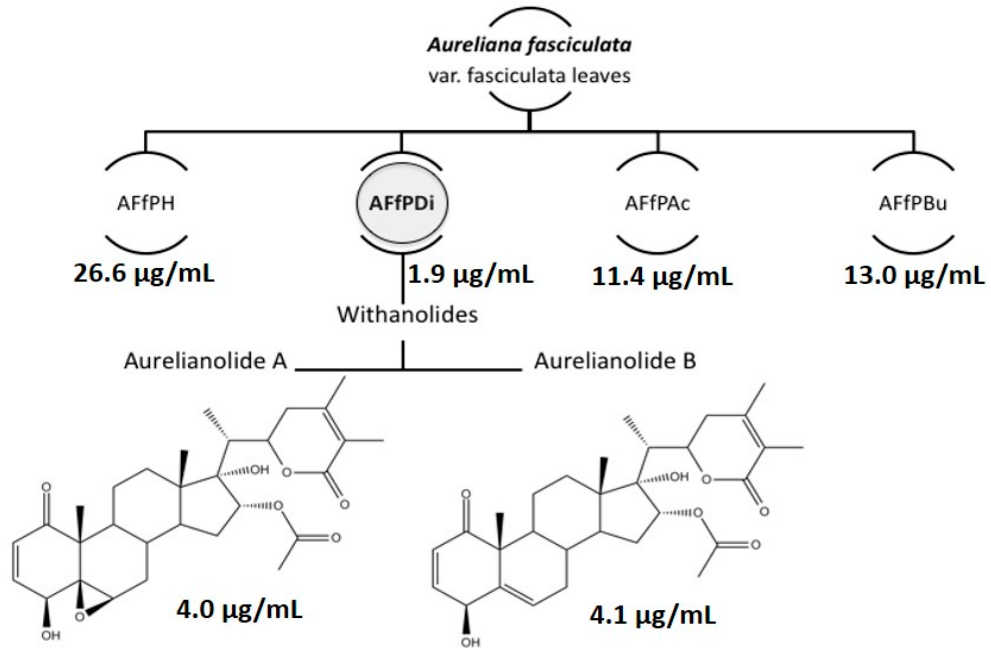
Figure 1. Antileishmanial-guided extraction of leaves of Aureliana fasciculata . AFfPH, hexane partition; AFfPDi, dichloromethane partition; AFfPAc, ethyl acetate partition; AFfPBu, butanol partition. The numbers refer to antipromastigote ICs 50 .